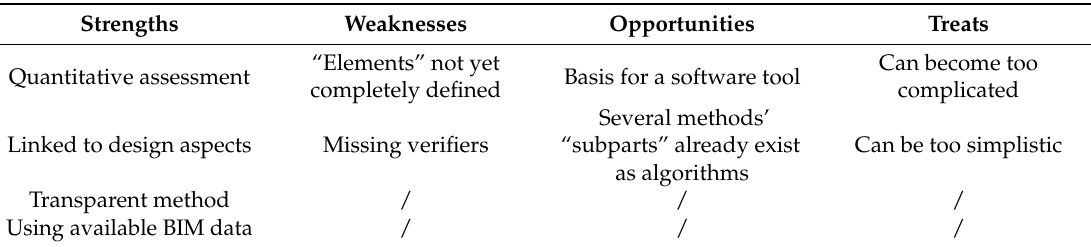
Table 6. SWOT (Strengths, Weaknesses, Opportunities, Threats) analysis of the DNA method in the current stage of development. Seeing the strengths and opportunities, the DNA method will be further developed in a software